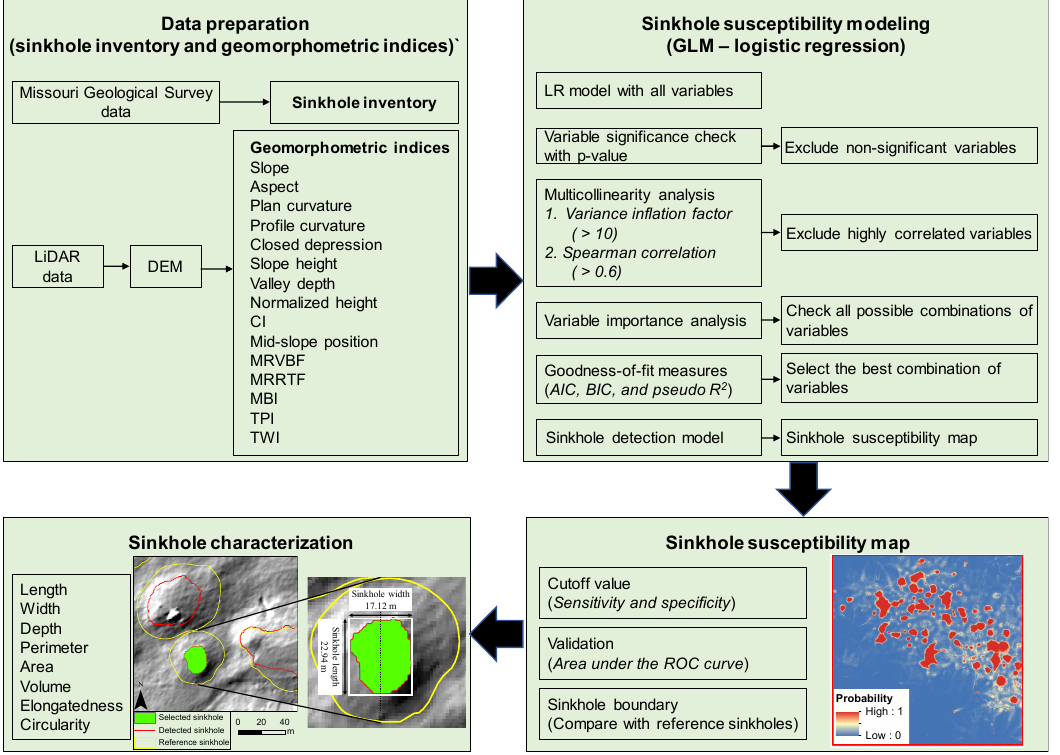
Figure 2. Flow chart of the study.